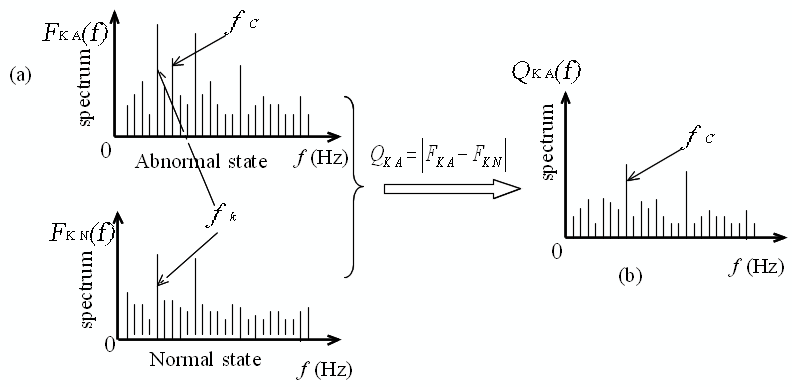
Figure 5. A simple illustration for spectrum difference. (a) Spectra of signals in the normal state and the abnormal state. (b) Difference